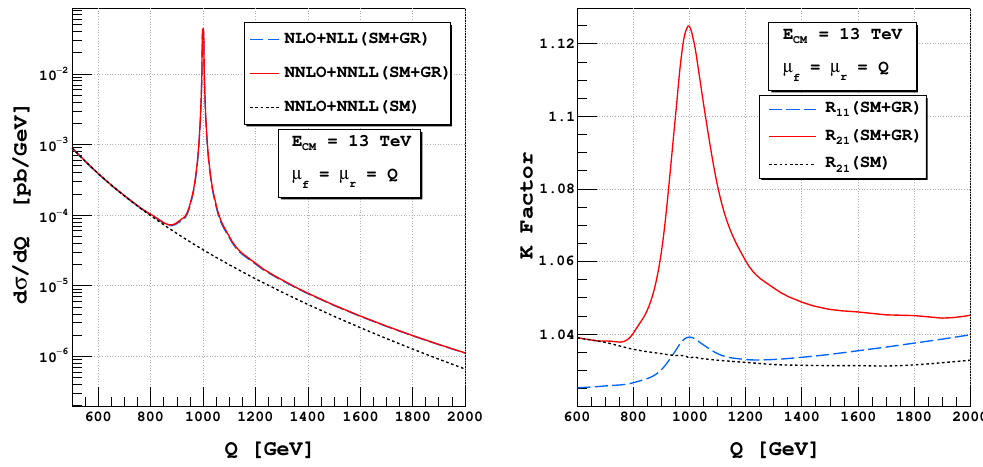
Figure 6 . Dilepton invariant mass distributions are presented to NNLO+NNLL QCD for signal (left panel) and the corresponding K -factors (right panel).